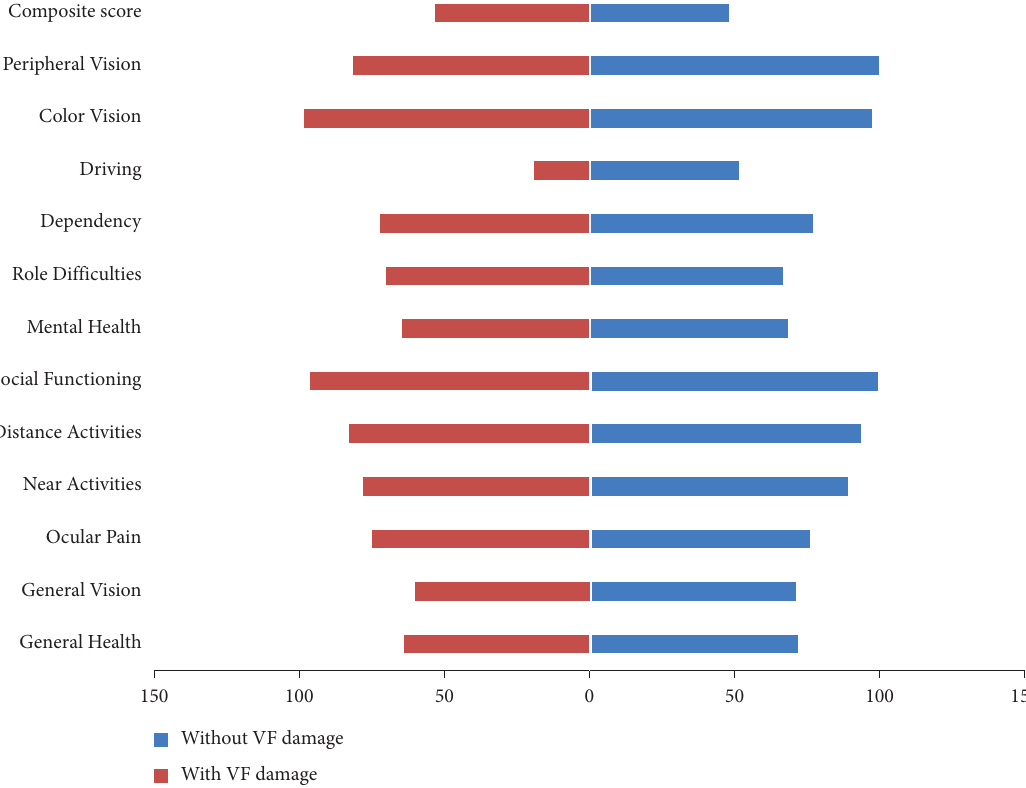
Figure 2: Te average scores of the NEI VFQ-25 between PACG patients with and without visual feld defects.